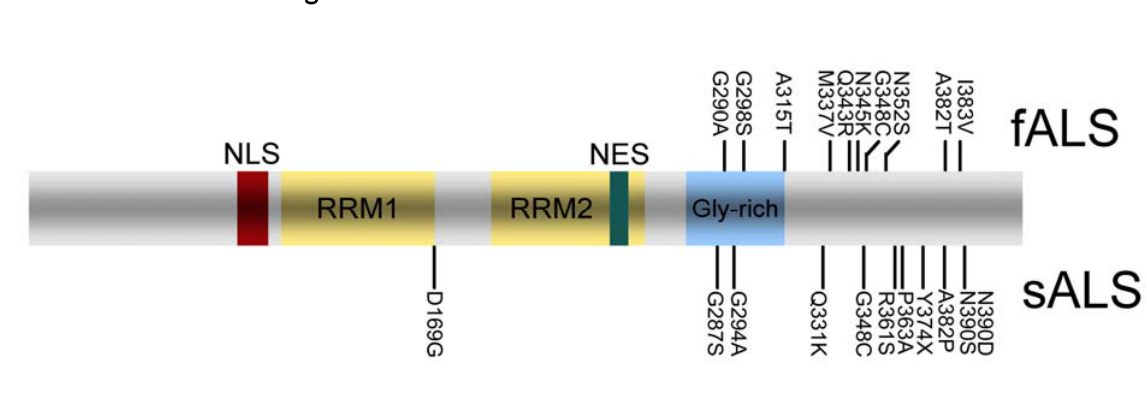
Figure 3. ALS associated mutations in